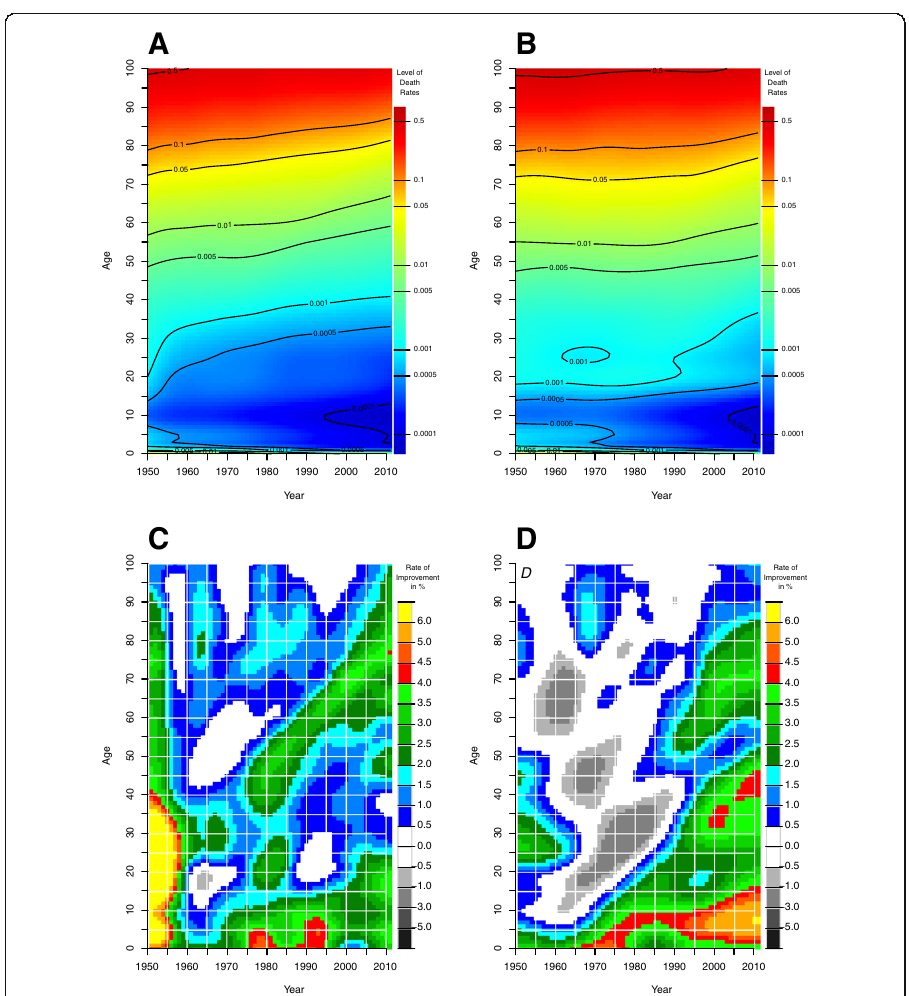
Fig. 8 Input of our model. Upper panel : death rates (smoothed) for men in the UK ( a ) and Denmark ( b ). Lower panel : rates of mortality improvement (in %) for men in the UK ( c ) and Denmark ( d ). Source: Authors ’ estimations based on data from the Human Mortality Database